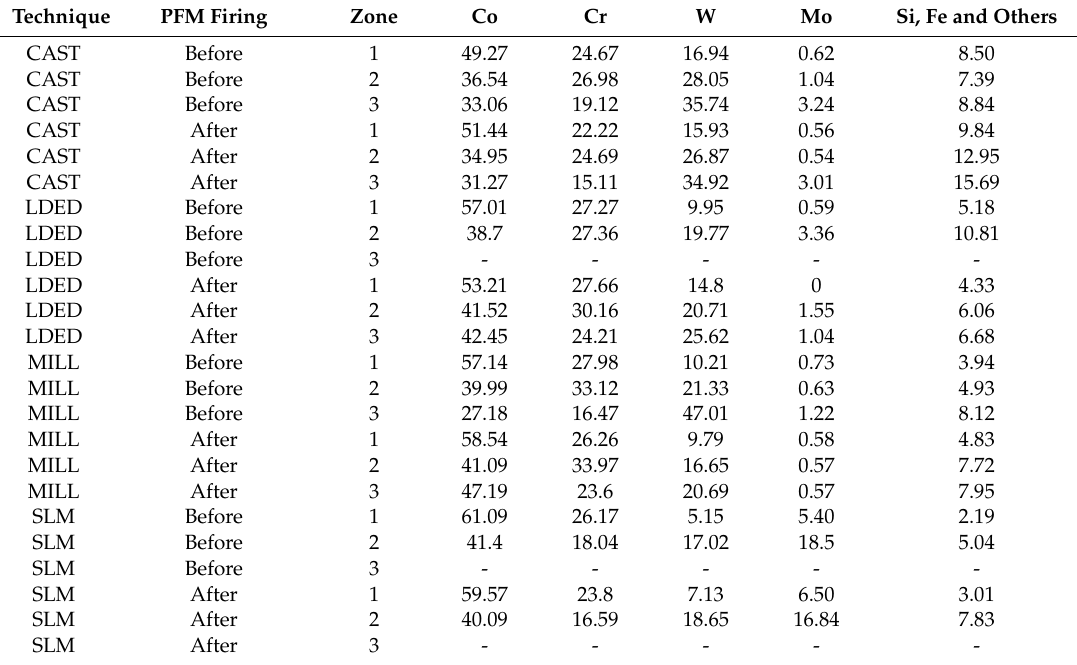
Table 3. Semi-quantitative chemical composition (wt.%) of the matrix 1 and segregation zones 2,3 determined by EDS. Before and after PFM firing simulation. Technique